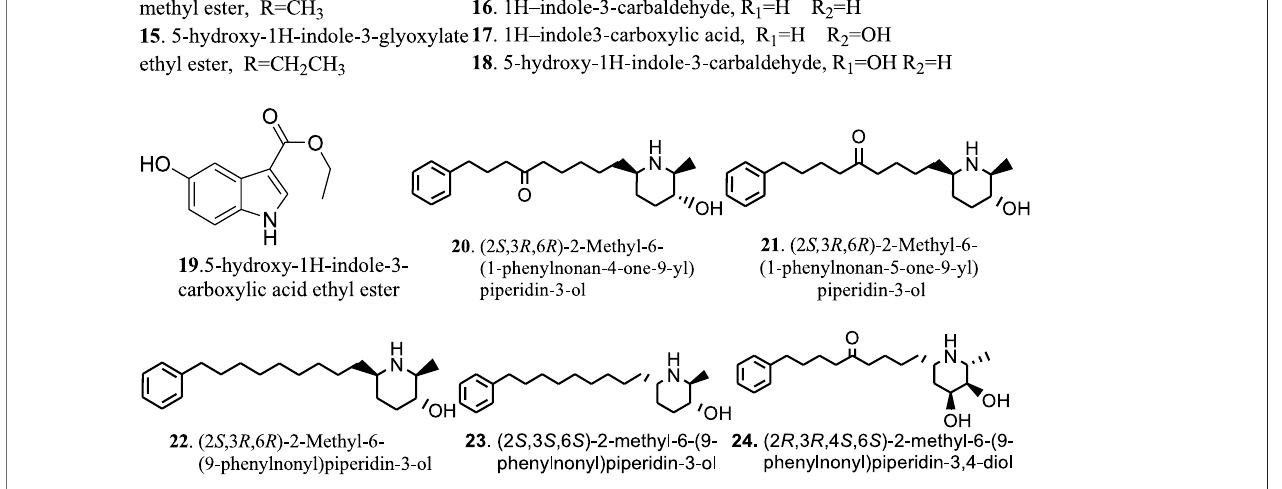
FIGURE 2 | Chemical structure of phytochemicals reported from Alocasia species.